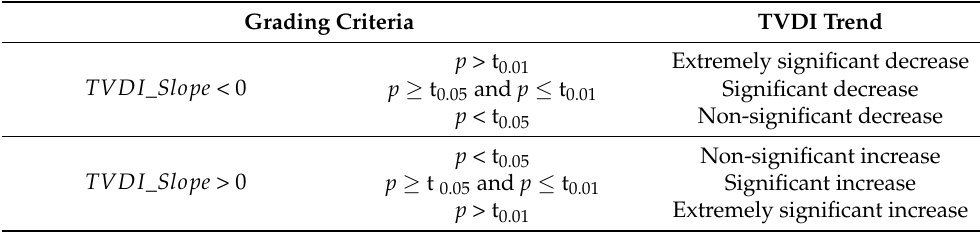
Table 3. Classification criteria of TVDI